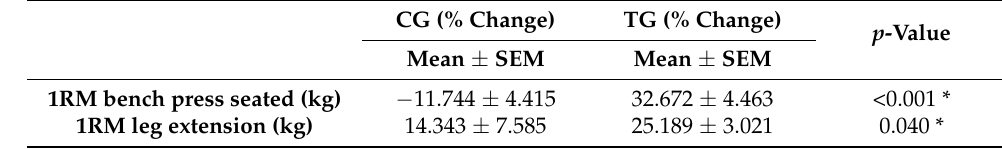
Table 2. Effect of an 8-week resistance training on muscular